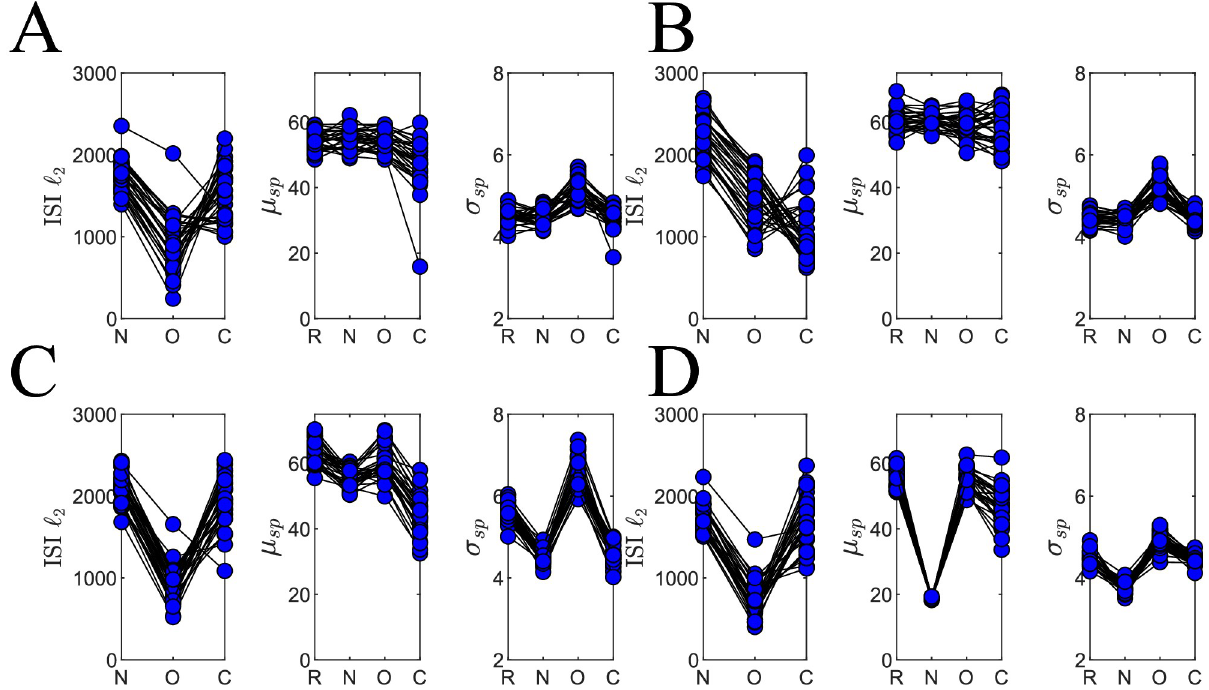
Fig 7. PSPM learning improves agreement of inter-spike interval (ISI) distributions. ( A ) The network-wide ISI distribution for the reference network most closely resembles the ISI of the optimized network ( C ) for this trial. The naive ( B ) and control ( D ) network ISI distributions both differ qualitatively from the reference ISI distribution. Thus the synapse specific changes called for by PSPM produces an ISI distribution similar to the